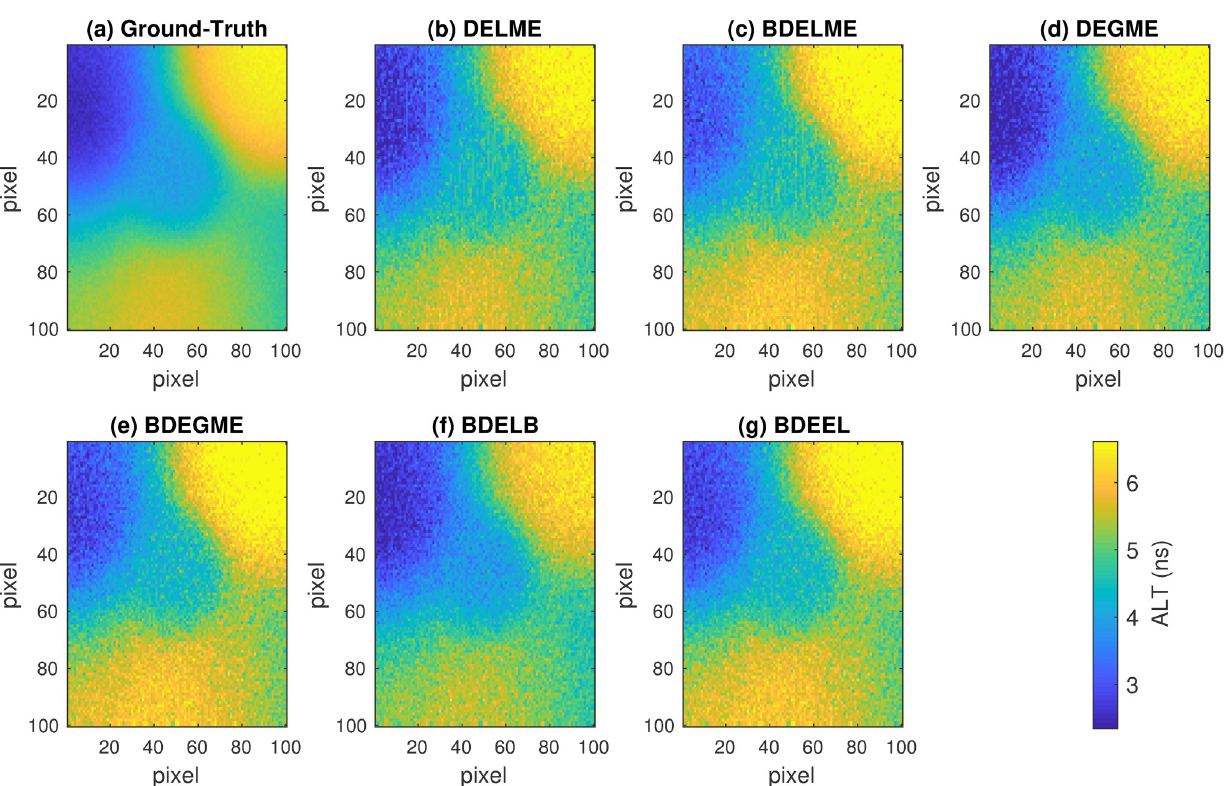
Fig 7. Average lifetime map for one realization in synthetic evaluation with 3rd order FluoIR model, SNR = 40 dB and PSNR = 10 dB: (a) Ground- truth, (b) DELME, (c) BDELME, (d) DEGME, (e) BDEGME, (f) BDELB, and (g) BDEEL.